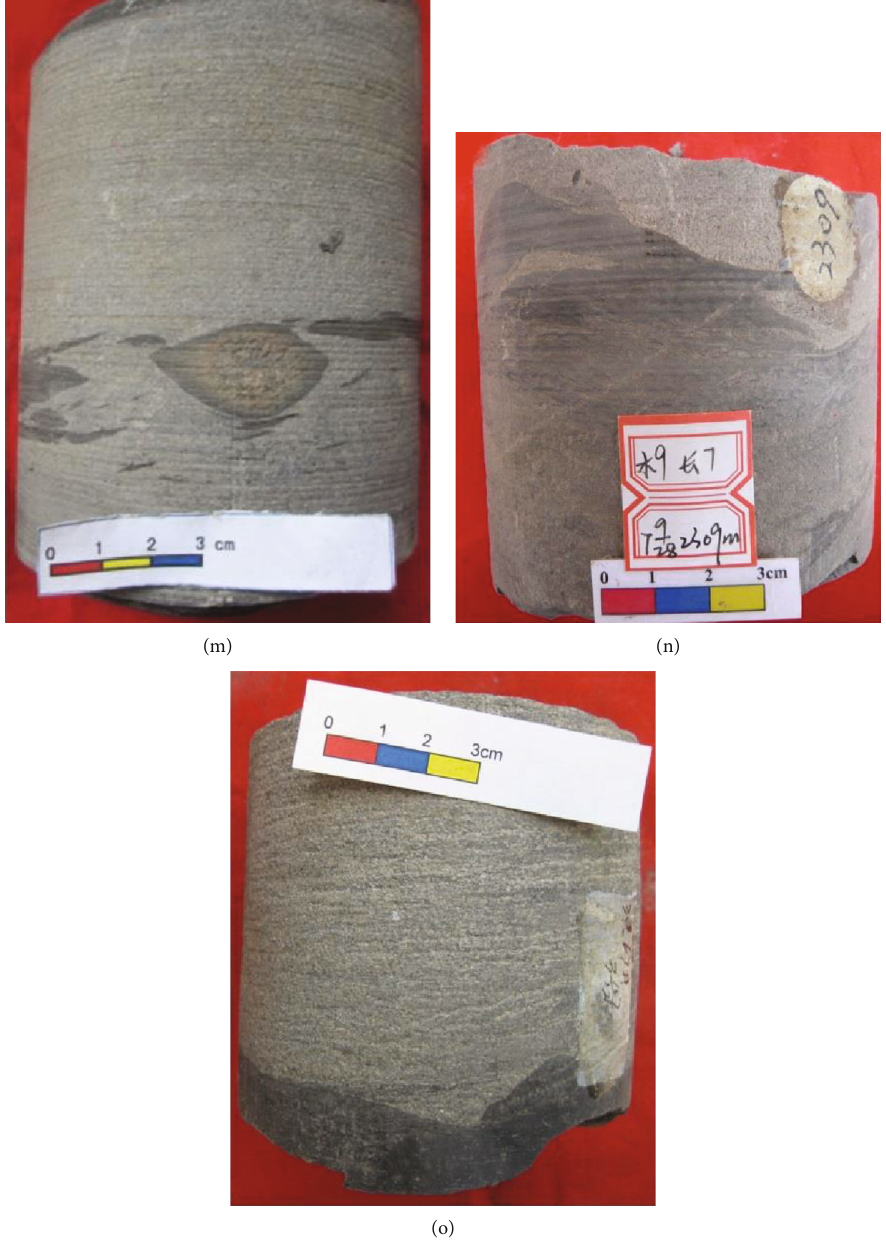
Figure 5: Turbidity current deposits, and sand debris fl ow deposits characteristics of Chang 7 interval in the study area: (a) Bouma sequences, Hongshiya pro fi le, Huanglong county; (b) Bouma sequences, Shiwang river pro fi le, Yichuan county; (c) Bouma sequences, Shanshui river pro fi le, Xunyi county; (d) Bouma sequences, Yaoqu pro fi le, Yao county; (e) fl ute groove casts, Yaoqu pro fi le, Yao county; (f) groove casts, Yaoqu pro fi le, Yao county; (g) fl ute cast, well Z24, Chang 72; (h) fl ame structure, well H25, Chang71; (i) fl ame structure, well H25, Chang71; (j) irregular mudclasts, well X41, Chang 72; (k) fl oating mudclasts, Yaoqu pro fi le, Yao county; (l) fl oating mudclasts, well ZT4, Chang7; (m) fl oating mudclasts and argillaceous parcel, well X99, Chang71; (n) sharp irregular contacts, well M9, Chang7; (o) sharp irregular contacts, well Y67,